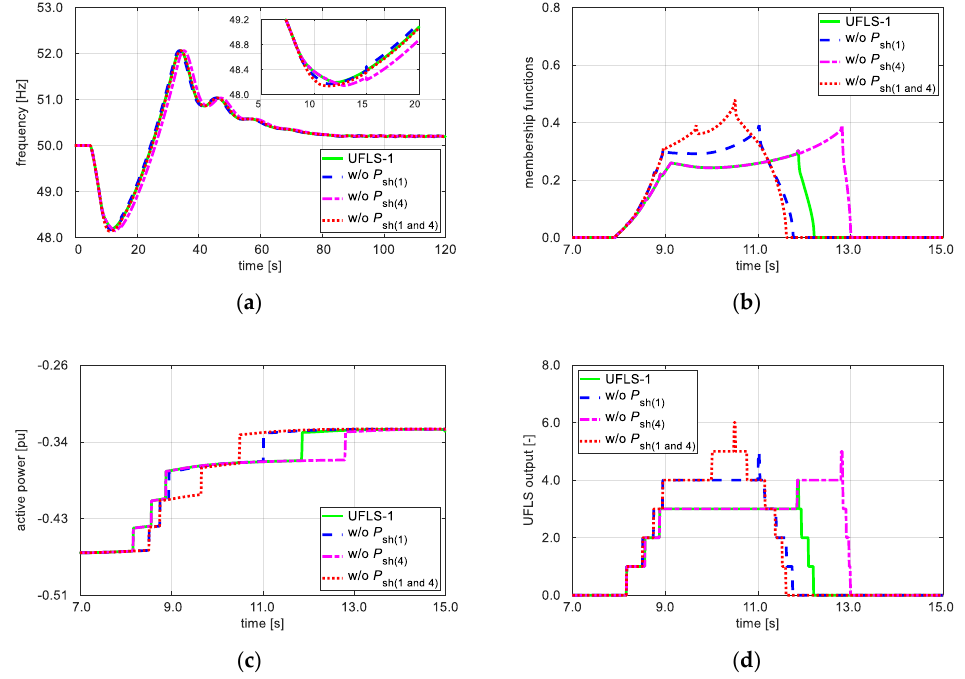
Figure 10. Time variation of selected variables during the unloading process under disconnecting failures: ( a ) frequency, ( b ) membership functions, ( c ) active power disconnected, ( d ) UFLS output